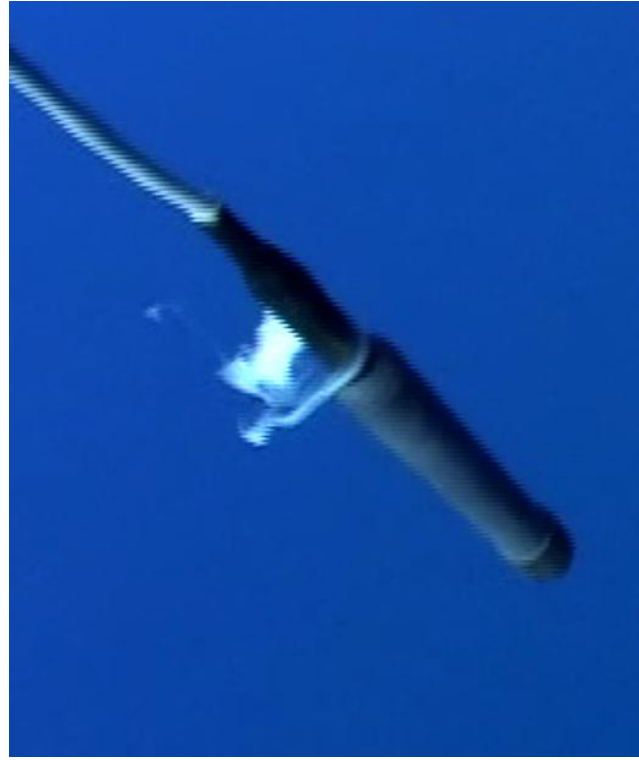
Figure 4. Milk recorded in the water column wrapped around hydrophone (1 m in length).